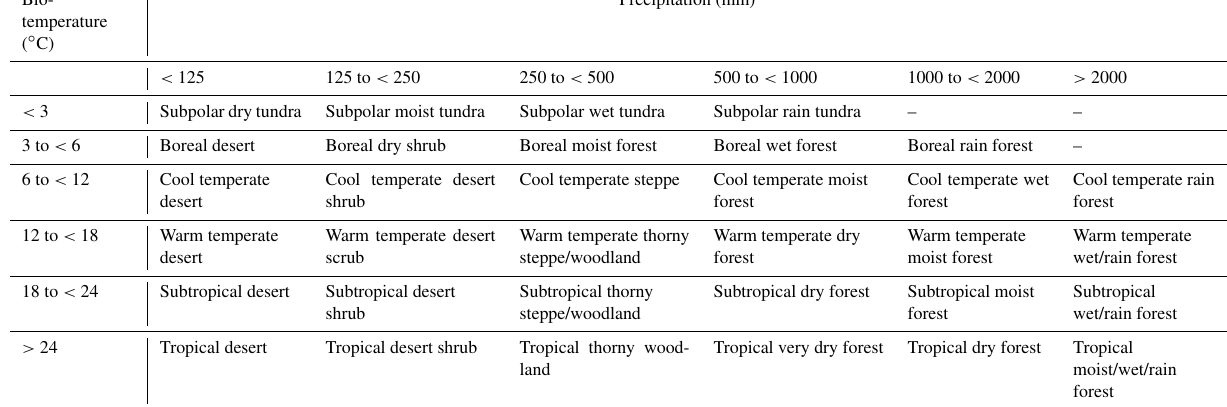
Table 3. The Holdridge life zones following Holdridge